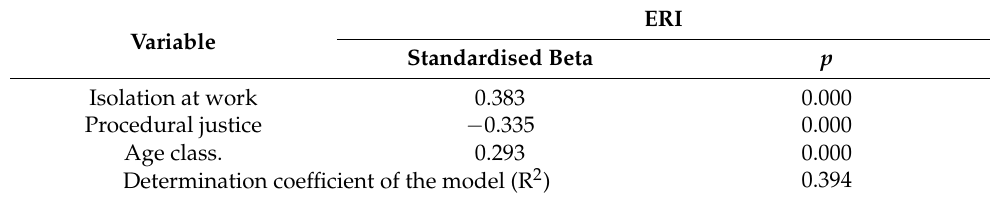
Table 4. Third wave stepwise linear regression analysis: the relationship between job changes and perceived work-related stress (ERI).